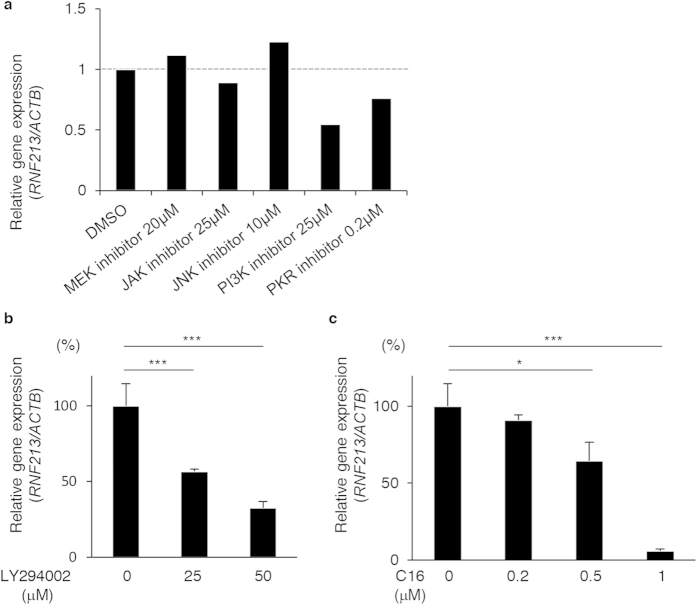
Phosphatidylinositol-4,5-bisphospate 3-kinase and double-stranded RNA-dependent protein kinase are the two upstream regulators of RNF213 expression.(a) Plots show the relative expressions of RNF213 mRNA in the presence or absence of protein kinase inhibitors for MEK (U0126, 20 μM), JAK (AG490, 25 μM), JNK (SP600125, 10 μM) and PI3K (LY294002, 25 μM) and PKR (C16, 0.2 μM). Mean values from two independent assays are shown. (b,c) Dose-dependent inhibition of RNF213 induction by LY294002 (b) and C16 (c). Relative expressions of RNF213 are plotted against various concentrations of PI3K and PKR inhibitors. Data are shown as values of mean ± SD from three independent assays and analyzed using Dunnett’s test (b,c). *p < 0.05, ***p < 0.001.